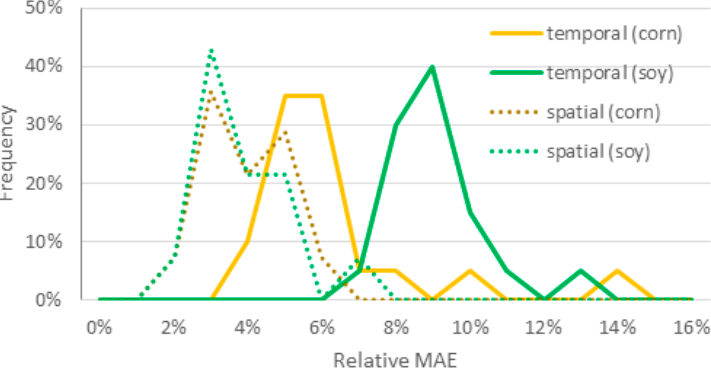
Figure 12. Histogram of RMAE from the spatial and the temporal (inter-annual) models. It shows that it is harder (larger RMAEs) to capture temporal variability of yield (solid lines) than spatial variability (dashed lines) when using VI alone. The RMAEs were computed using small cumulative EVI2 from day 192–236.